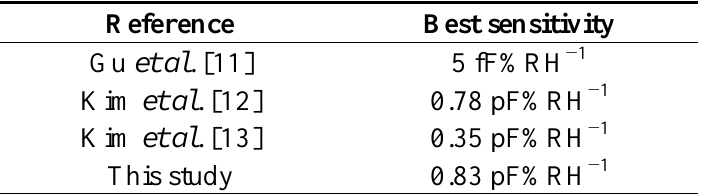
Table 1. Comparison of sensitivity for different capacitive humidity sensors using polyimide presented in the